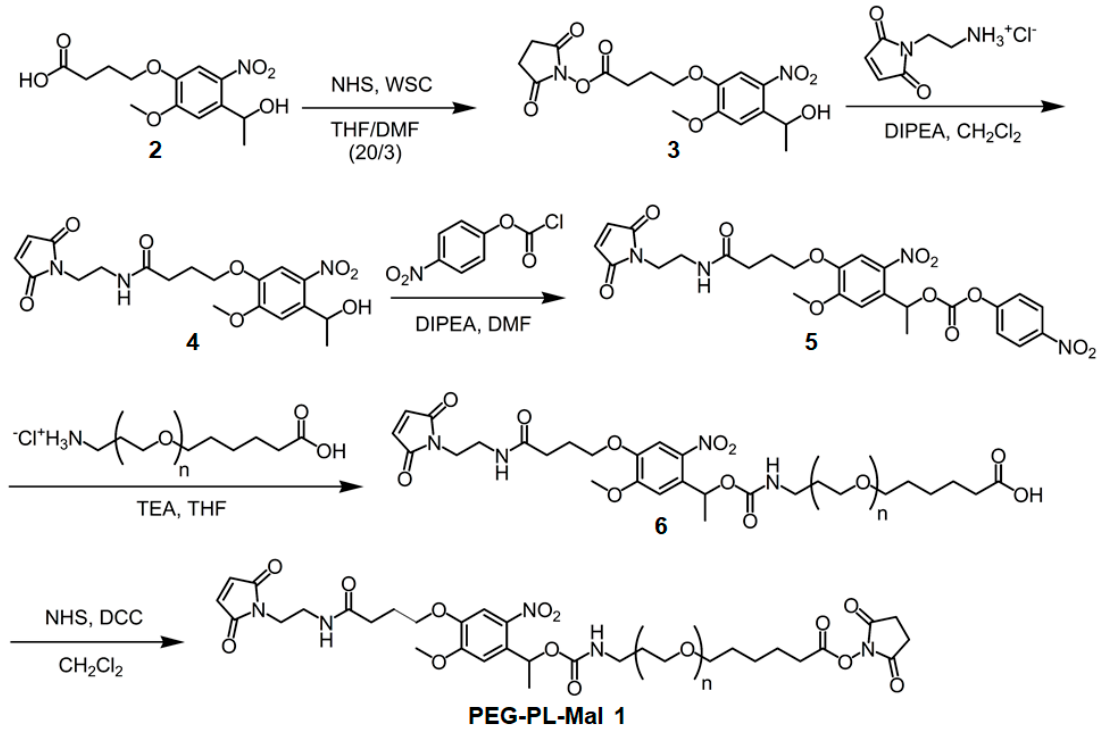
Scheme 1. Synthetic scheme of PEG-PL-Mal